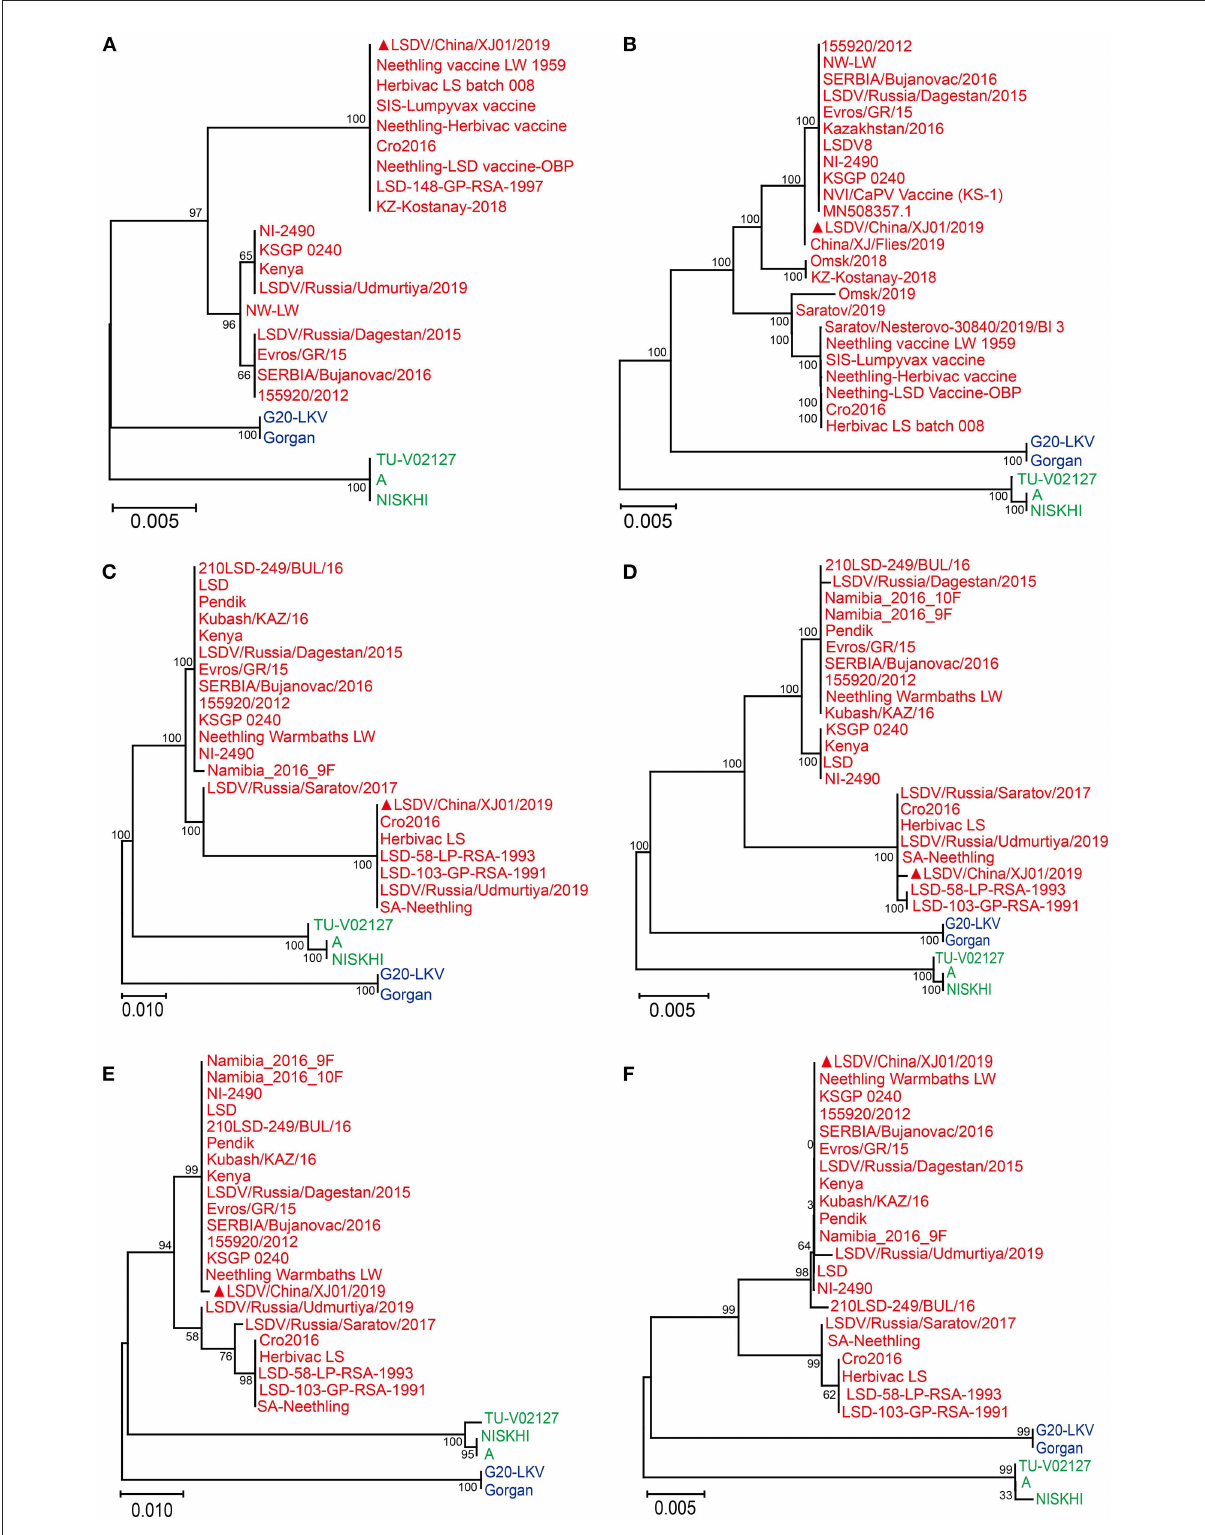
FIGURE1 Phylogenetic diagram of RPO30 (A) , GPCR (B) , Putative alpha amanitin-sensitive protein (C) , Ankyrin repeat protein gene (D) , Interleukin-1 receptor-like protein gene (E) and Putative late transcription factor (F) genes of Lumpy skin disease virus. The phylogenetic tree was constructed using MEGA 11 with the Maximum Likelihood method. The Lumpy skin disease virus, Sheeppox virus, Goatpox virus are labeled with red, blue and green colors, respectively. The sequences obtained from this study are indicated by solid red